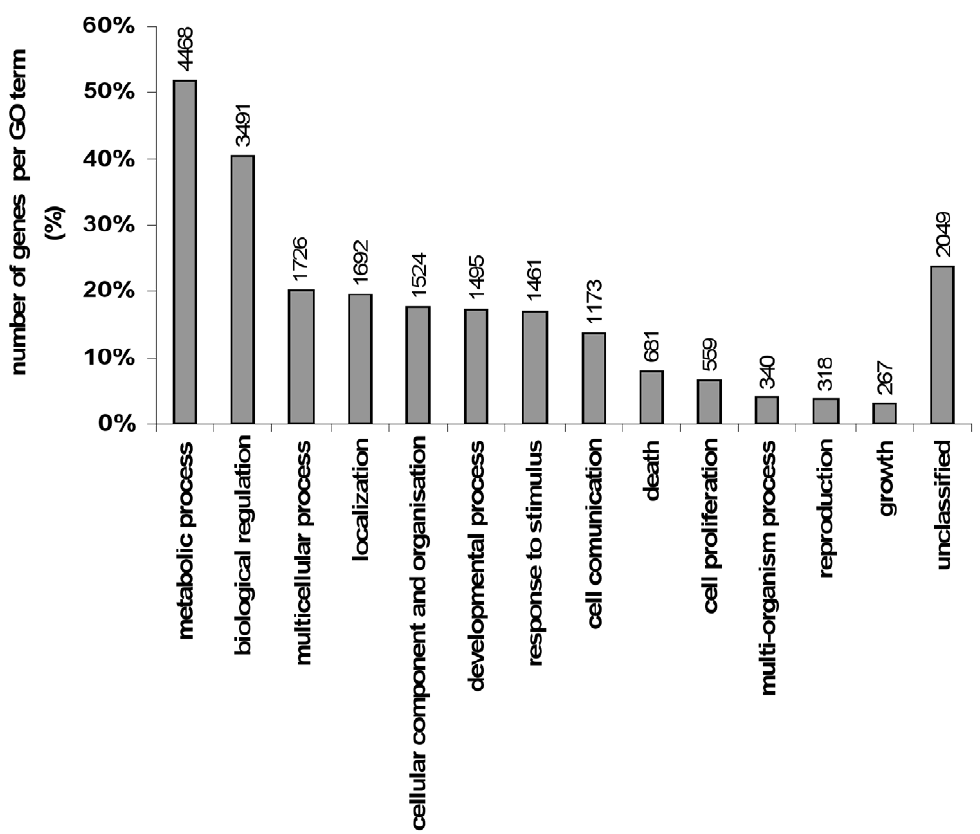
Figure 1. Microarray Biological Process (GO Slim) classification. Each Biological Process category is represented by a bar. The height of the bar represents the percentage of genes observed in the category. The number of genes per category is indicated upon the bars